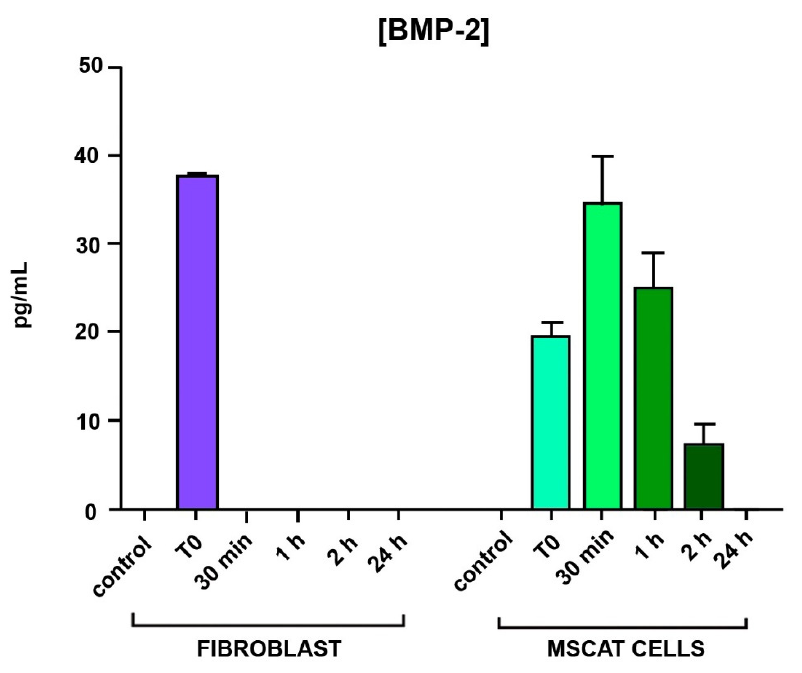
Figure 12. Measurements of BMP-2 levels in fibroblast and MSCat cultures by enzyme-linked immunoassay (ELISA) techniques at different study times.